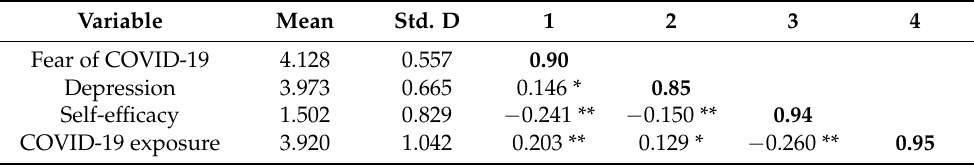
Table 2. Descriptive statistics, reliability, and correlation.